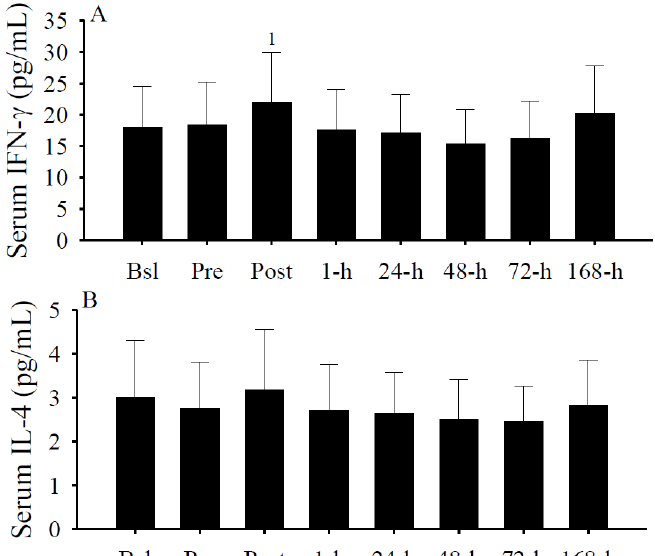
Figure 6. Serum IFN-γ and IL-4 concentrations (pg/mL). Serum IFN-γ concentrations ( A ) were significantly ( 1 p < 0.05 vs. 1-h, 48-h, and 72-h) increased at Post. Serum IL-4 concentrations ( B ) were not significantly different. Data presented as mean ±